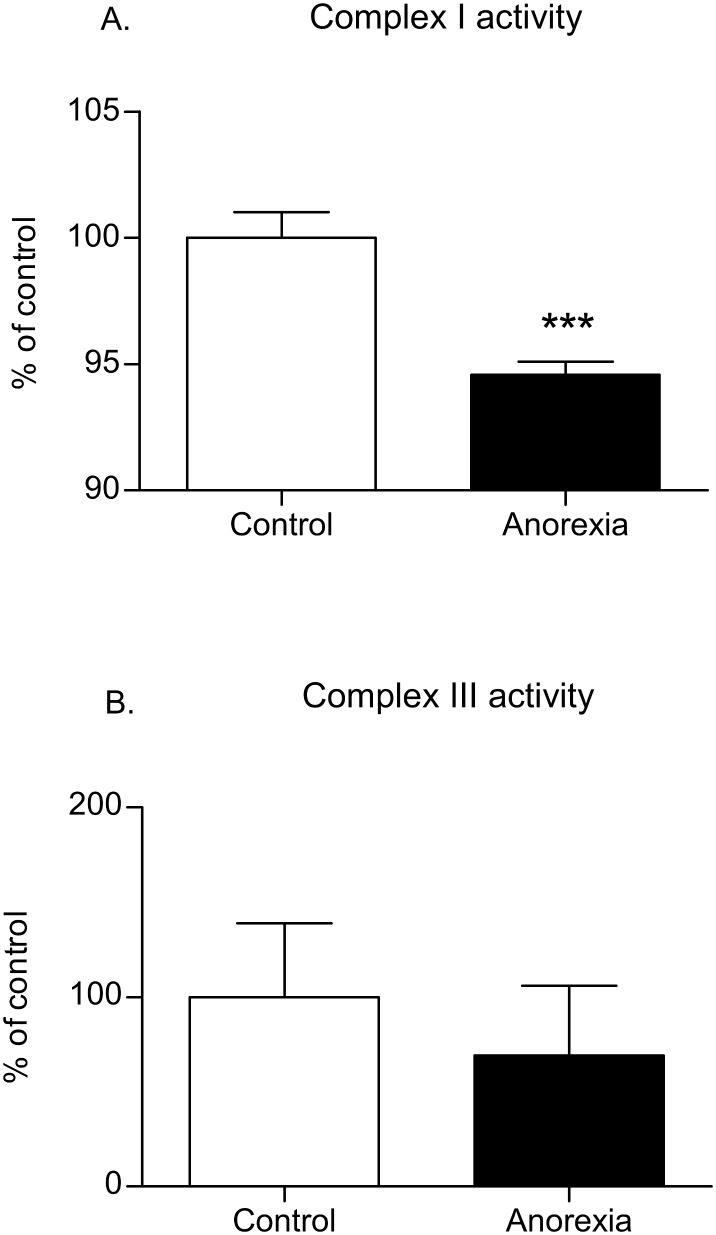
Effect of anorexia on mitochondrial complex I activity (A), measured as the NADH oxidation rate at 340 nm, and on complex III activity (B), measured as the cytochrome C reduction rate at 550 nm.Specific inhibitors for complexes I and III, rotenone and antimycin A, respectively, were employed to ensure the specificity of the assay. n = 8 per group. ***P<0.001 vs. control.